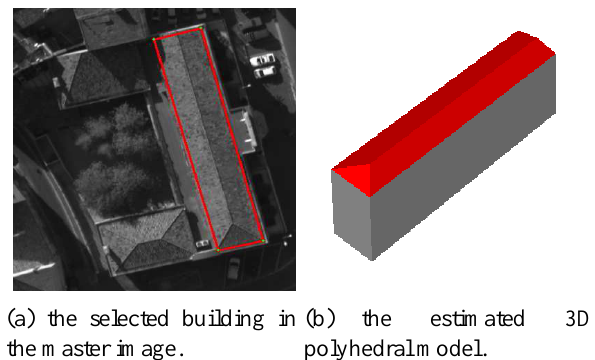
Figure 14. Estimated 3D polyhedral building model and related